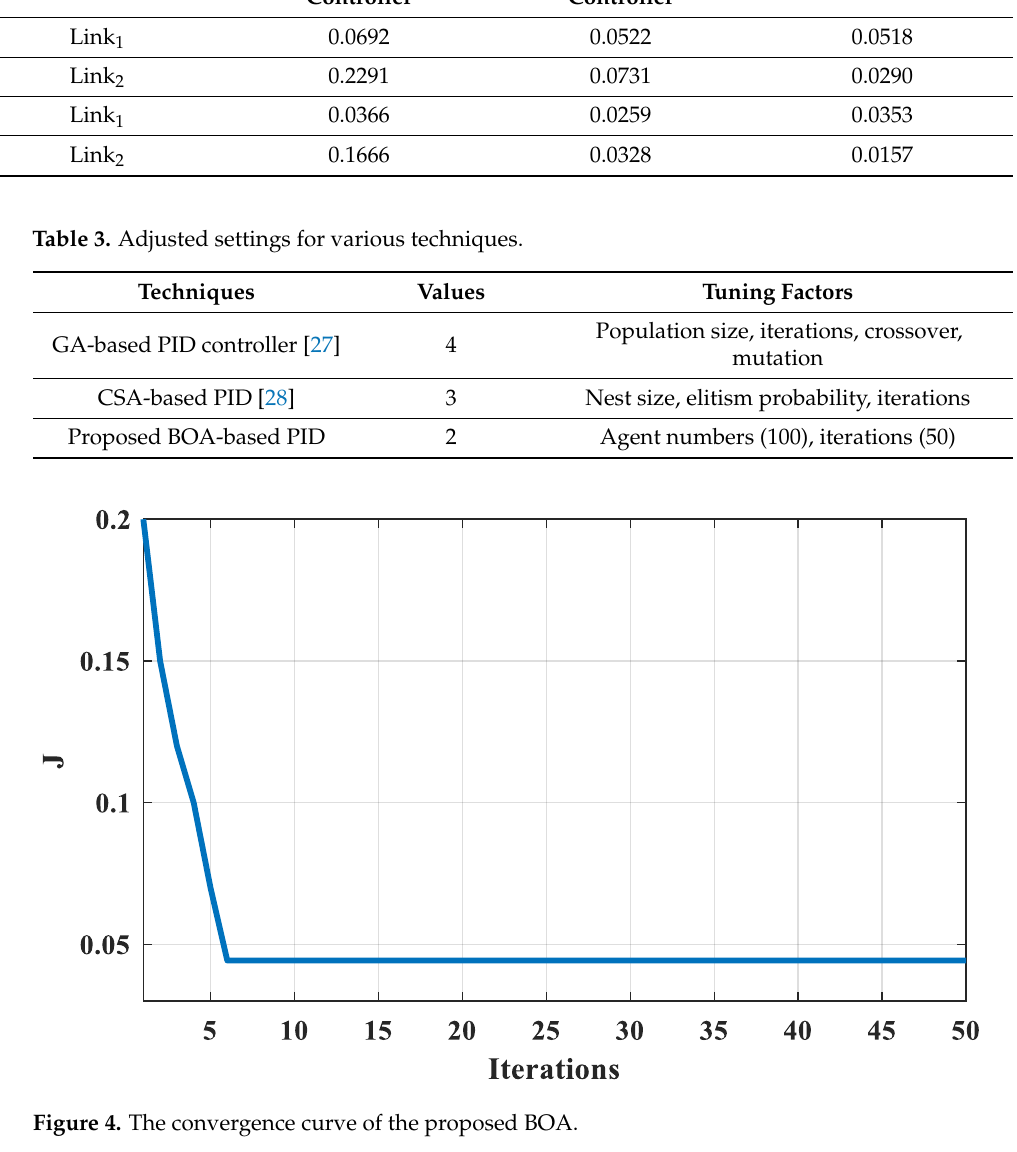
Figure 5. The output response of link1 in the case of Scenario 1.